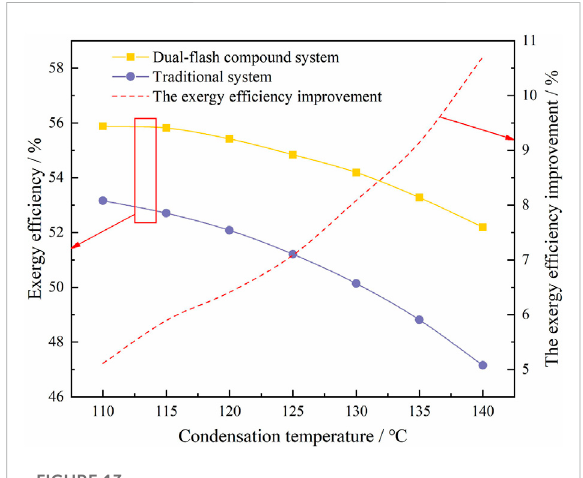
FIGURE 13 The trend of exergy ef fi ciency of the system under the same cooling